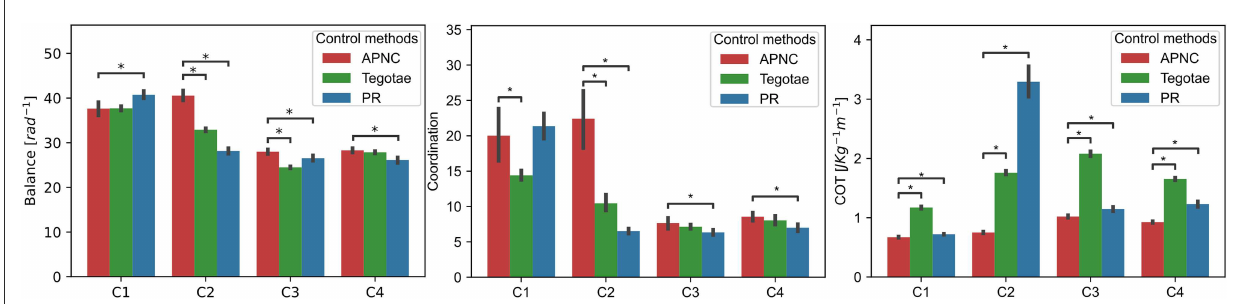
FIGURE7 Comparison of the robot’s walking performance under three different control methods (APNC, Tegotae, and PR) under four conditions (C1: normal condition, C2: noisy feedback, C3: leg damage, and C4: carrying payload (see Supplementary Table S5). To compare the performance of the control methods, a Mann-Whitney test was used. * denote significant differences with the following p ≤ 0.05. Note that the coordination metric is based on the duty factor. Thus, the low variance of the duty factor characterizes well-coordinated locomotion behavior (see also Supplementary Equations S4–S7).